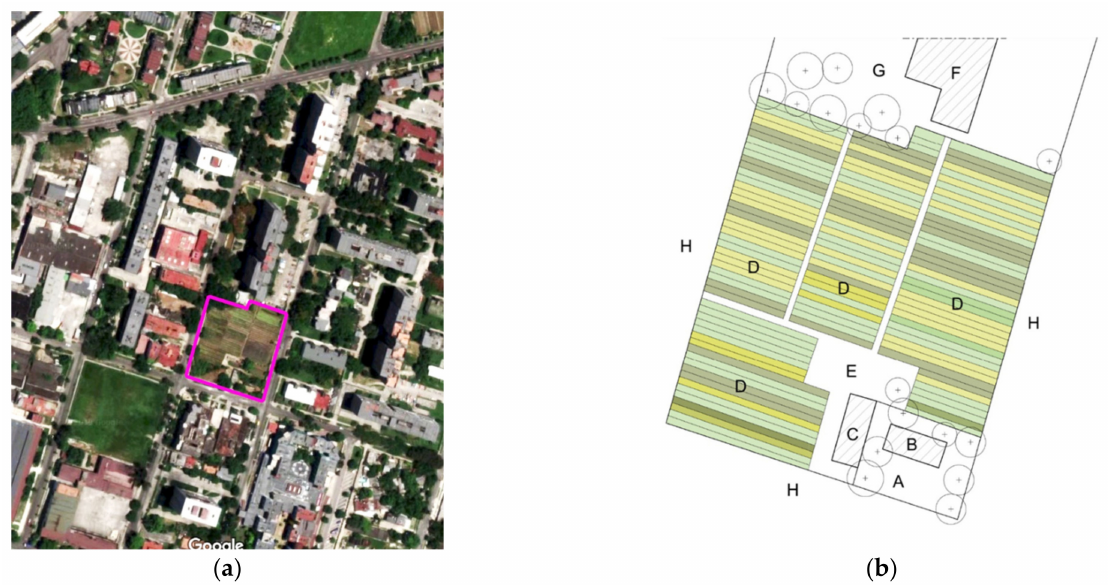
Figure 6. Organop ó nico La Sazon (Havana): ( a ). Location of the La Sazon farm in Havana [original study, based on: www.google.pl/maps, (access on 16 August 2018)]; ( b ). Scheme of the La Sazon farm. Explanation: A—entrance area (public space), B—market (store), C—storage room, D—crop beds, E—utility space, F—residential building, G—recreation area in a residential area,